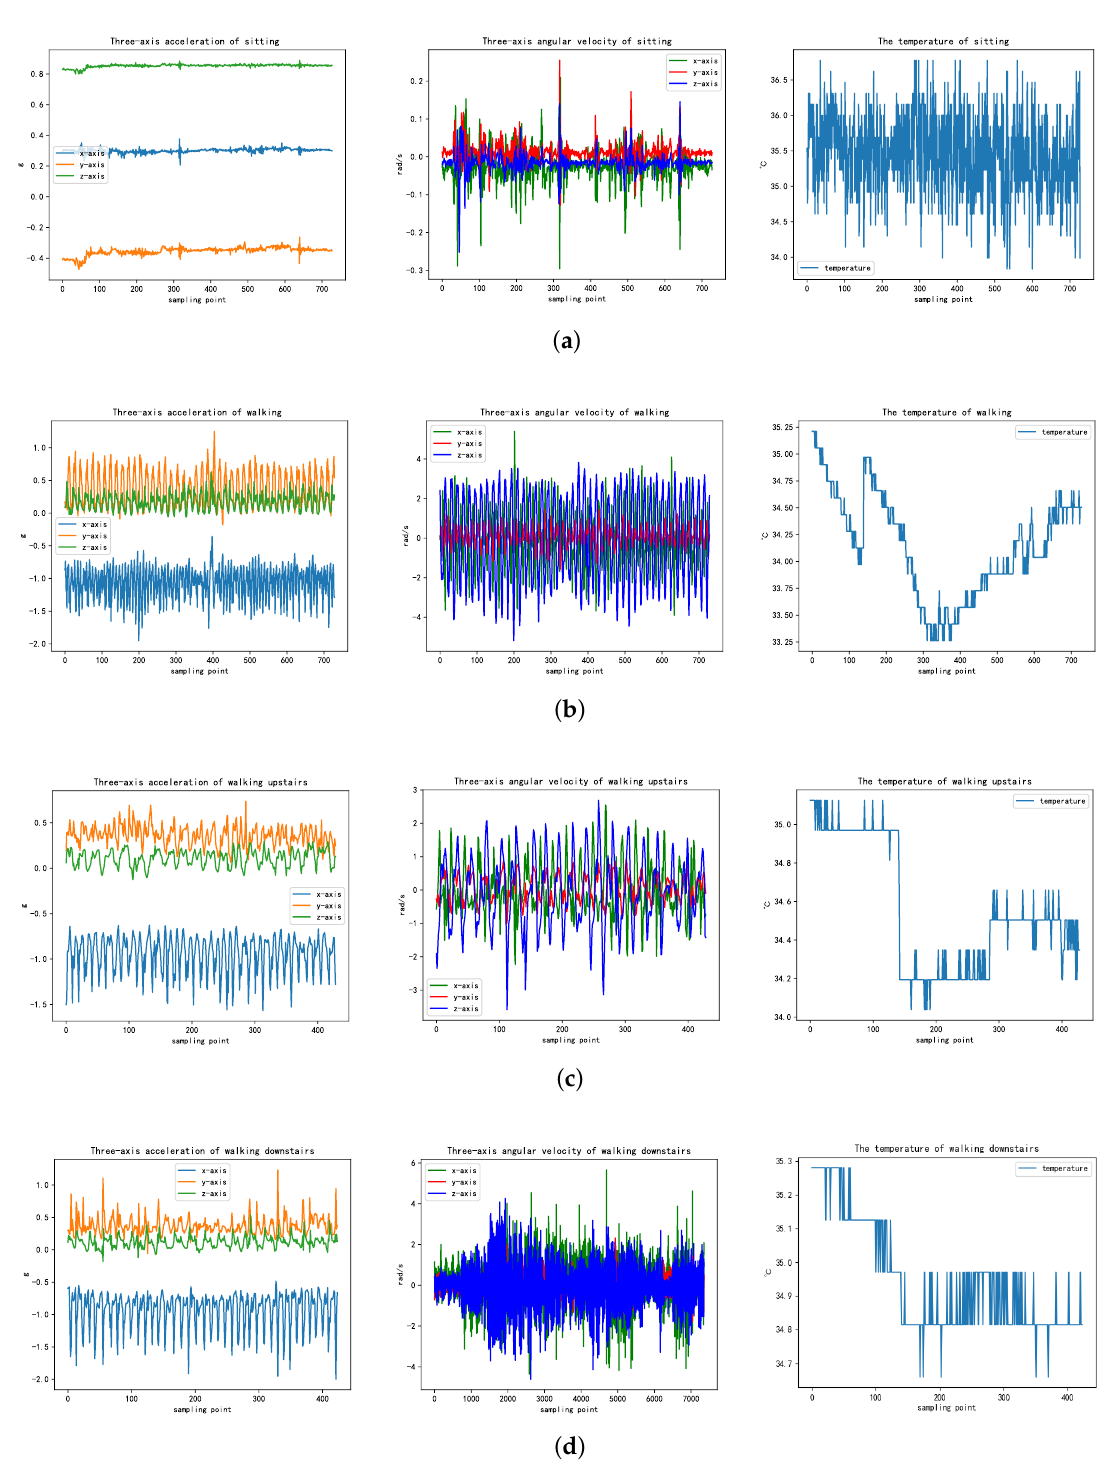
Figure 4. Visualized sensing signal curves for four activity patterns (sitting, walking, walking upstairs and walking down- stairs). ( a ) Sitting with acceleration, velocity and temperature sensing signal curves. ( b ) Walking with acceleration, velocity and temperature sensing signal curves. ( c ) Walking upstairs with acceleration, velocity and temperature sensing signal curves. ( d ) Walking downstairs with acceleration, velocity and temperature sensing signal